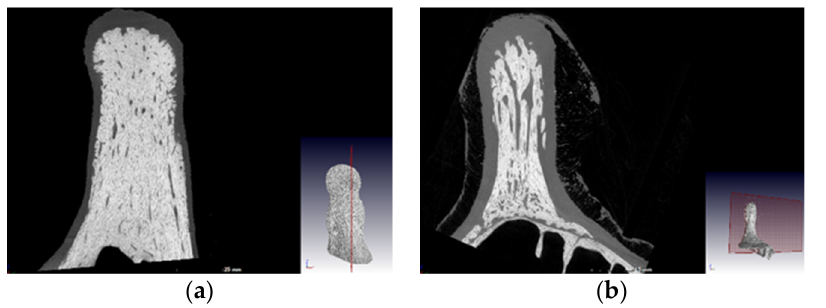
Figure 2. Computerized tomography (CT) scan images of the internal structure of the ossicones of ( a ) a giraffe bull and ( b ) a giraffe